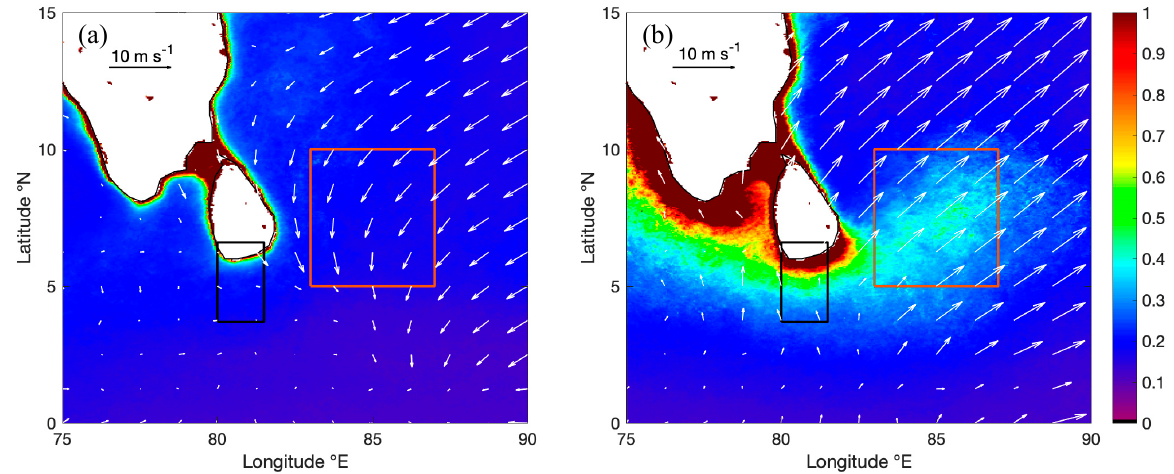
Figure 2. Seasonal mean chlorophyll concentration (units: mg m − 3 ) overlaid by wind fields during ( a ) northeast monsoon (December–April) and ( b ) southwest monsoon (June–September). White arrows denote wind vectors. The red and black boxes denote the region of SLD (5–10 ◦ N, 83–87 ◦ E) and SSL (3.7–6.6 ◦ N, 80–81.5 ◦ E), respectively.